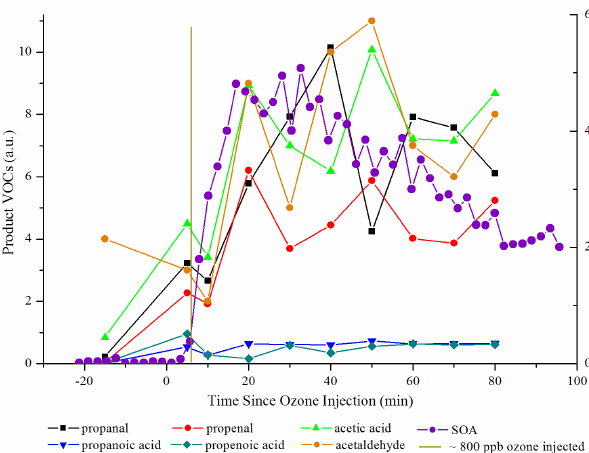
Fig. 6b. In addition to the evolution of SOA, the ozonolysis of grass clippings also resulted in the evolution of several volatile products, including propanal, propenal, acetaldehyde and acetic acid. Trace amounts of propenoic acid, and propanoic acid, were measured. Several of these volatiles products have not previously been re- ported as products of CHA or HXL ozonolysis. Lines between data points drawn to aid the eye.